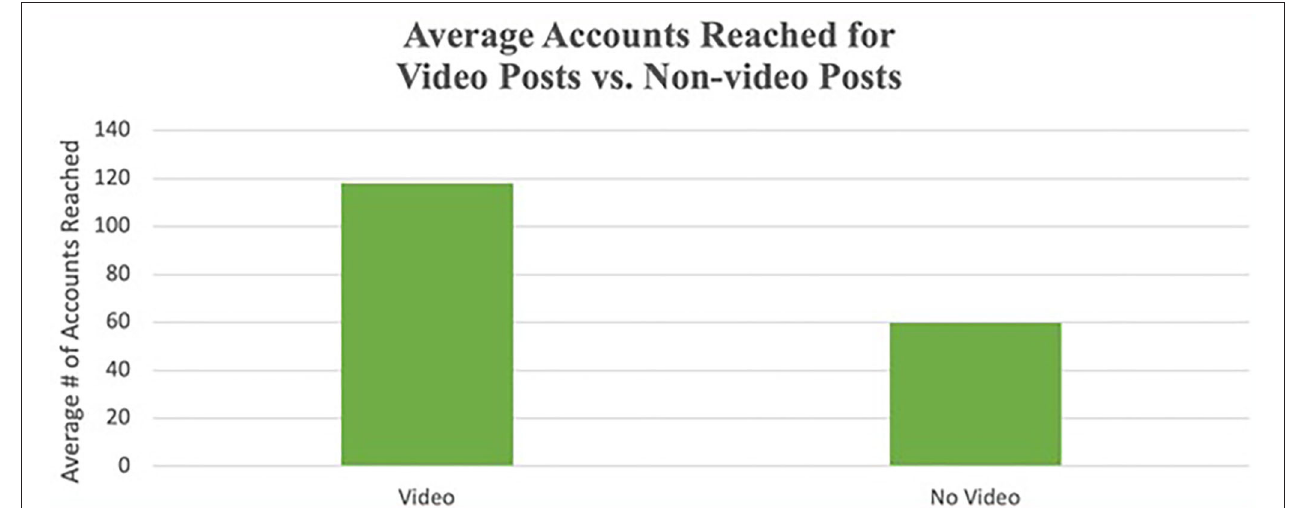
FIGURE 6 | Average accounts reached for video posts vs. nonvideo